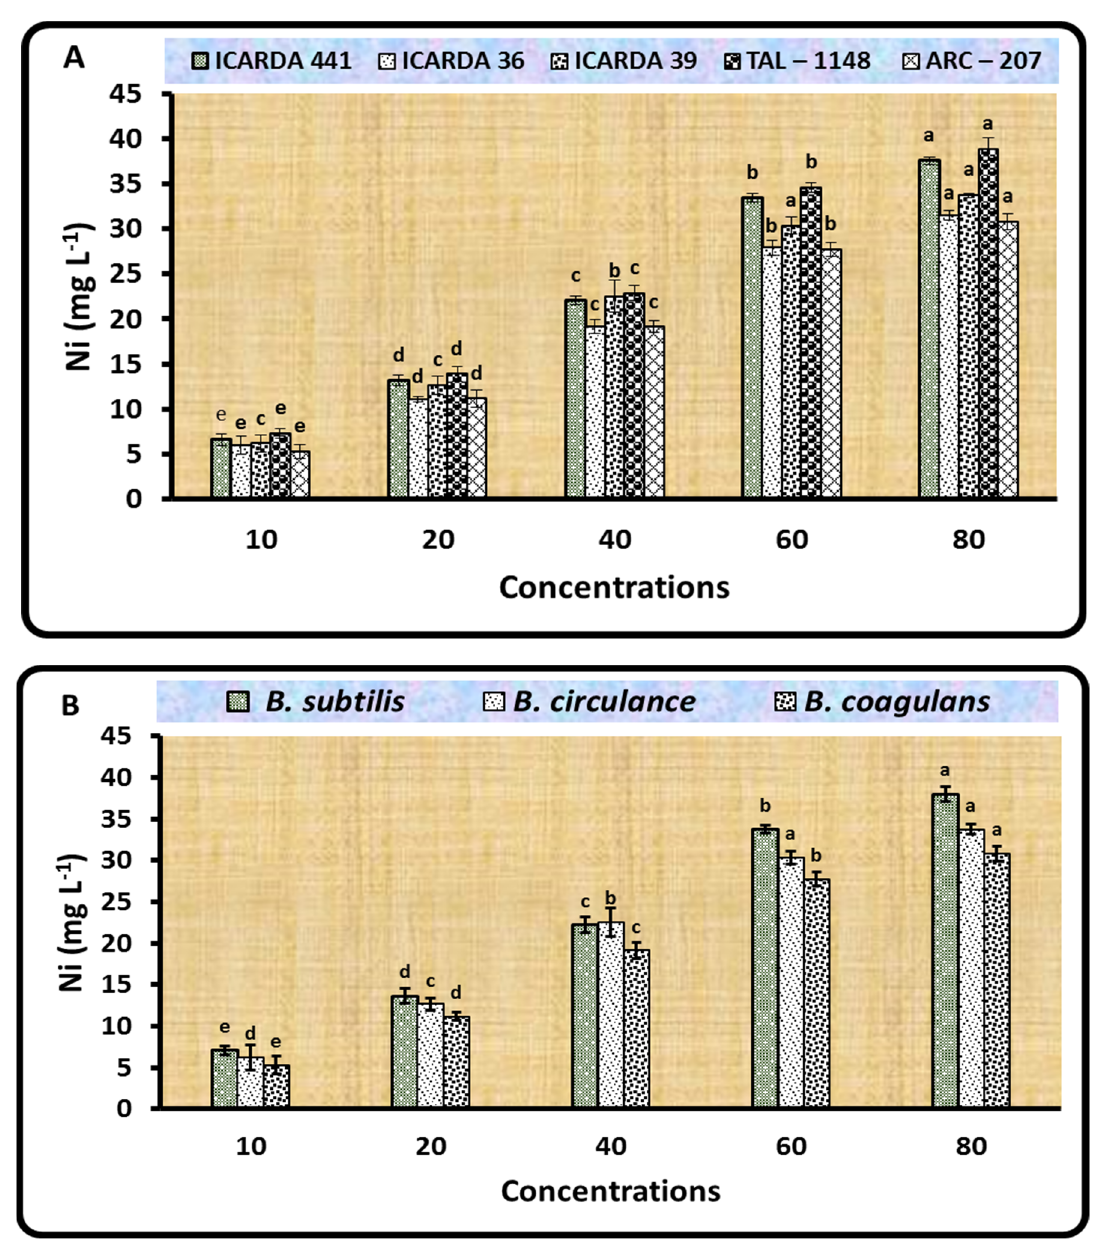
Figure 1. Biosorption of different concentrations of Ni (10, 20, 40, 60, and 80 mg L − 1 ) by Rhizobium isolates ( A ) and Bacillus strains ( B ). According to Duncan’s test ( p < 0.01), means followed by various letters show significant differences between the treatments. a–e : Duncan’s letters.